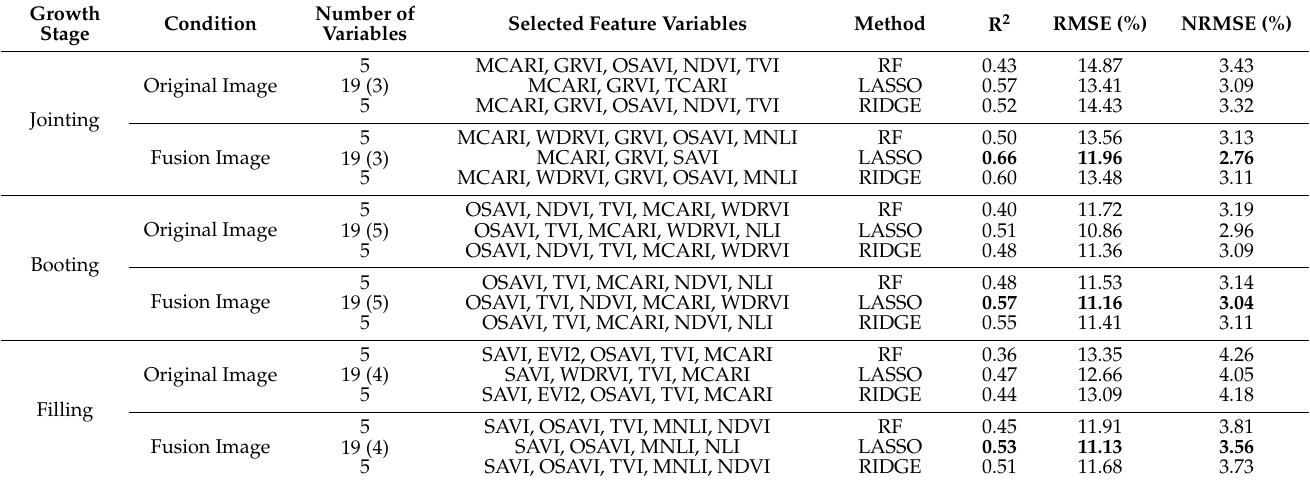
Table 4. Predictive performance of Rice LNC using the RF, LASSO and RIDGE algorithms for both original and fusion images.